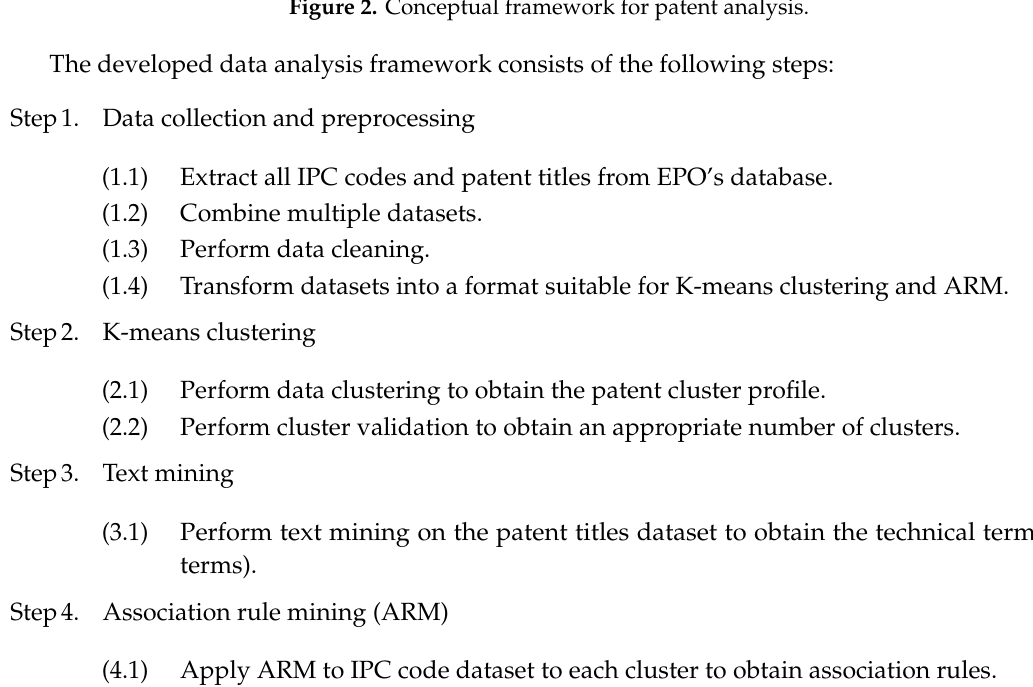
Figure 2. Conceptual framework for patent analysis .